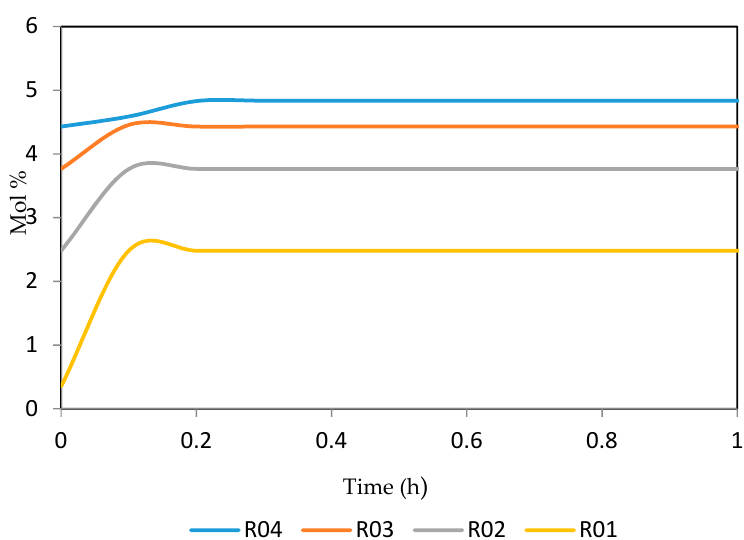
Figure 30. Dynamic behaviour of A 10 in the four reactors.